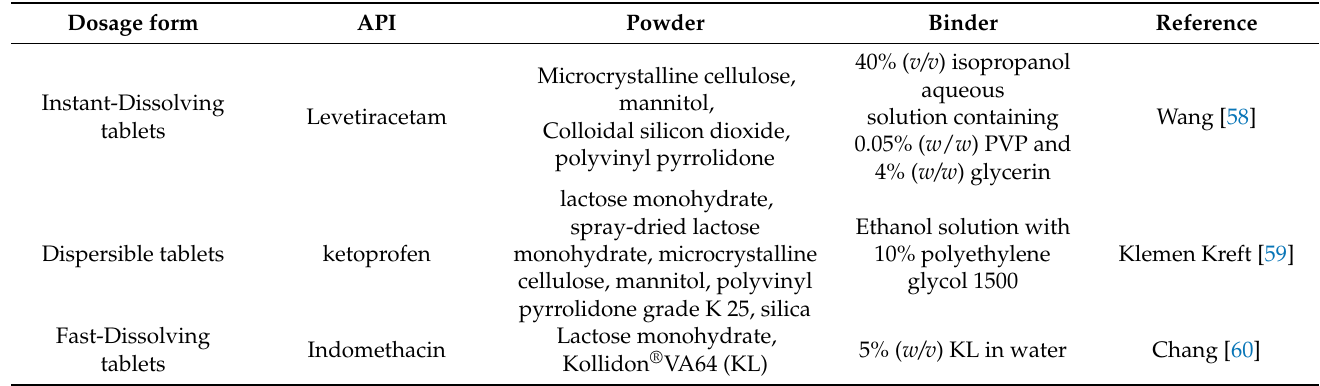
Table 1. Examples of rapid-release formulations that have been used in recent research on binder jet 3D